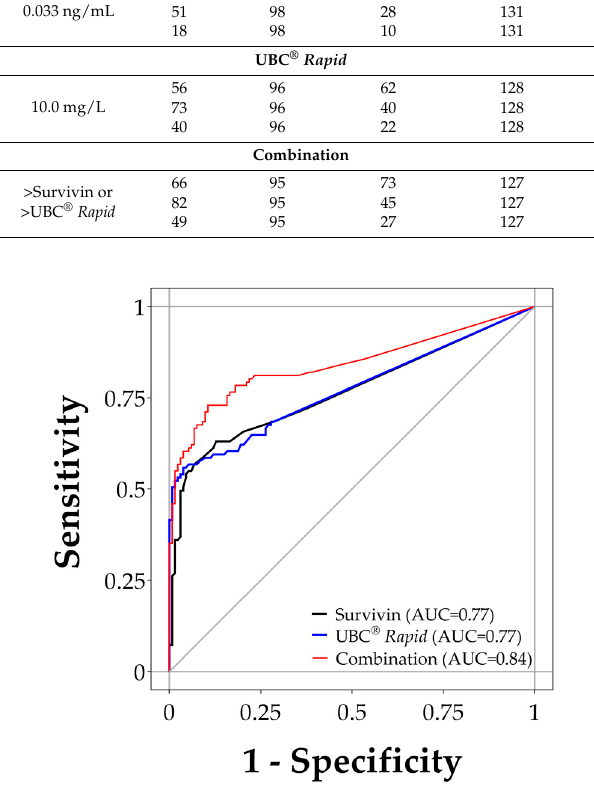
Figure 3. ROC analyses of survivin and UBC ® Rapid . ROC curves for survivin (AUC = 0.77), UBC ® Rapid (AUC = 0.77), and the combination of both assays (AUC = 0.84) based on comparing tumor and clinical control group.